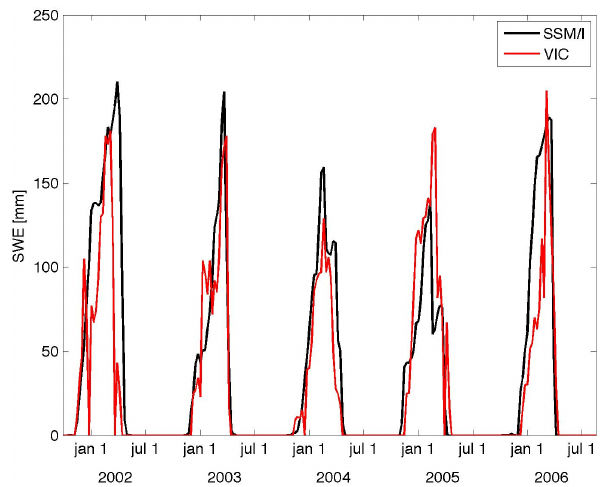
Fig. 5. A comparison of modeled (red) and observed (black) SWE at a location in southeastern Turkey (40.5 ◦ E longitude, 38.5 ◦ N lat- itude) within the Euphrates-Tigris basin for 2001–2006. The ob- served data are extracted from the 8-day blended Special Sensor Microwave Imager (SSM/I) data (Brodzik et al., 2007).